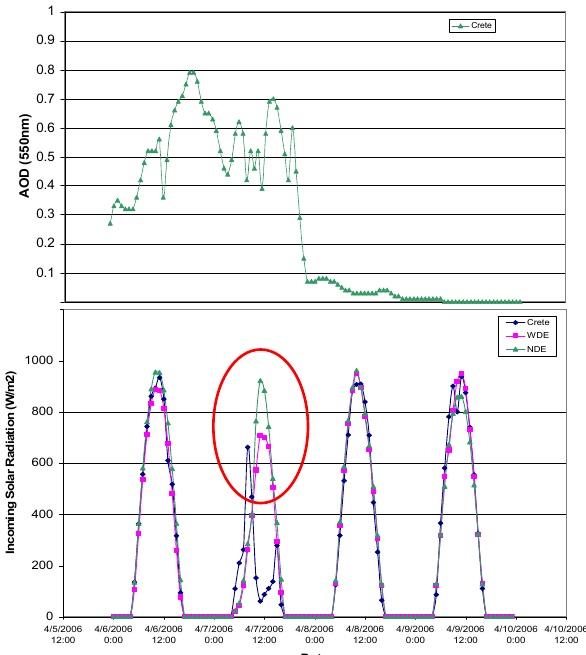
Fig. 3. Aerosol optical depth (AOD) at 550nm at the station in Crete (top) derived from SKIRON model. Comparison of the in- coming solar radiation at the surface inWm − 2 (bottom) as mea- sured from the station in Crete (blue line) and as simulated by the SKIRON/Dust system with the two model setups (WDE – purple line; NDE – green line). The cloudy period is marked with the red oval.